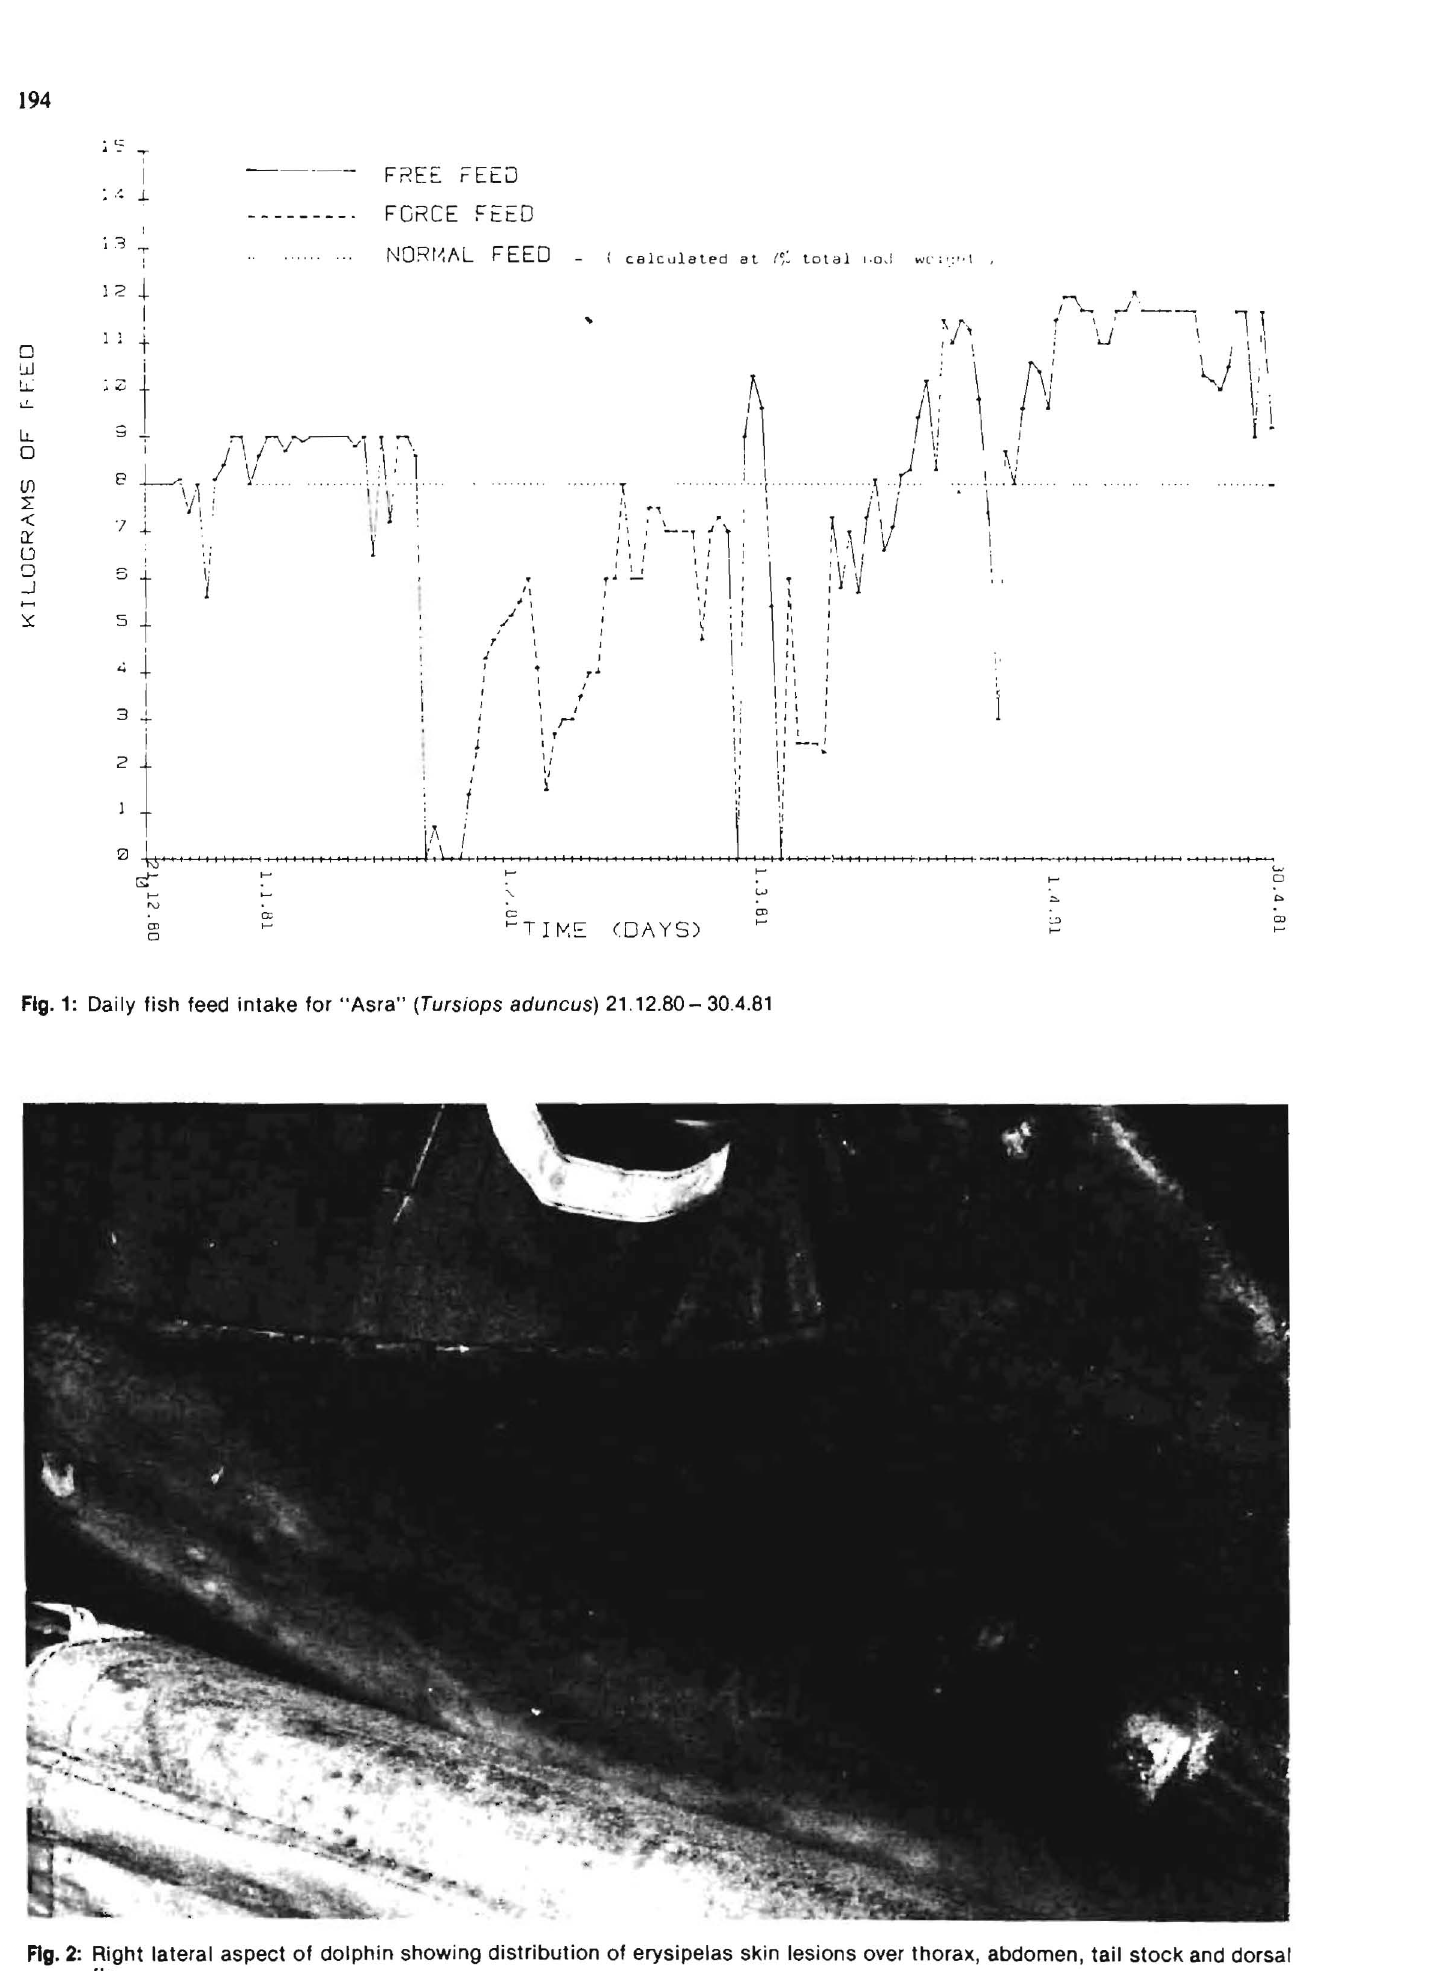
Fig. 2: Right lateral aspect of dolphin showing distribution of erysipelas skin lesions over thorax, abdomen, tail stock and dorsal fin. TYDSKRIF V AN DIE SUID-AFRlKAANSE VETERIN~RE VERENIGING - SEPTEMBER